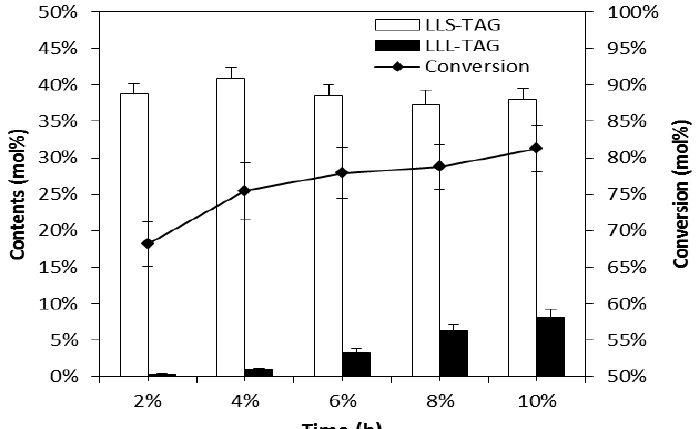
Figure 4. Effects of enzyme loading on interesterification of SLCTs at 24h. The reaction mixture of 9.7 g FAME/triacetin (3:1mol/mol) and different amount of Novozyme 435 was stirred at 50 °C. LLS-TAG, the content of LLS-TAGs; LLL-TAG, the content of LLL-TAGs; Conversion, the conversion of